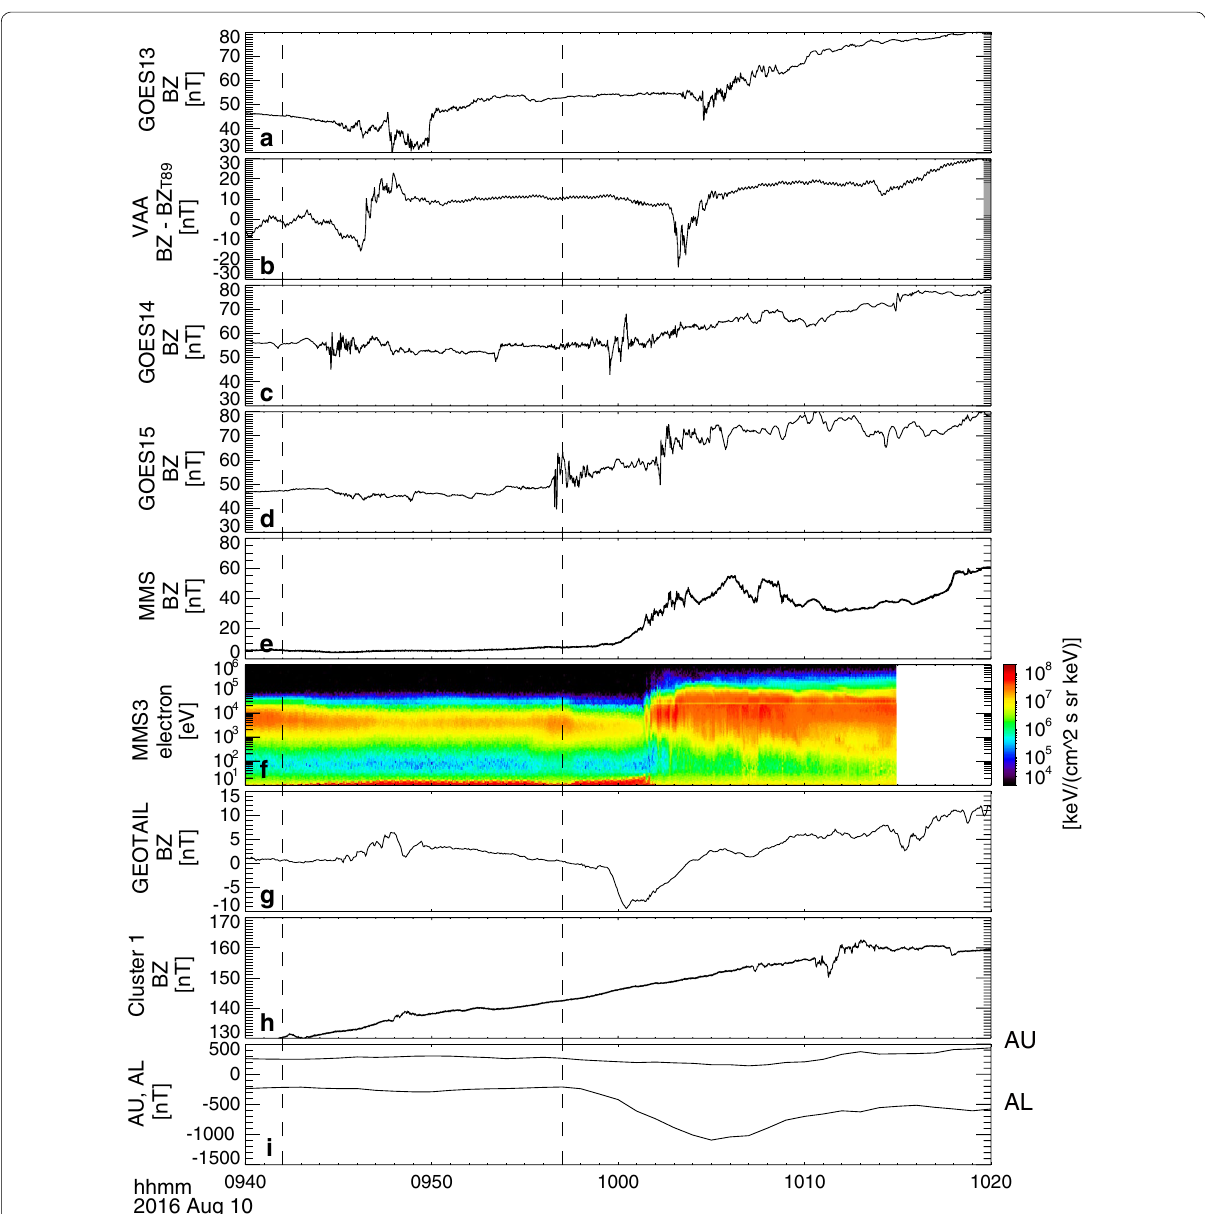
Fig. 2 Multispacecraft observations of dipolarization. Magnetic field component normalized to the current sheet ( B Z ) observed in the night‑side magnetosphere is plotted from the post‑midnight to pre‑midnight regions: a GOES 13, b Van Allen Probe‑A, c GOES 14, d GOES 15, e MMS3, g Geotail, h Cluster 1, together with f a combined product of energy spectra of electrons from MMS1 and MMS3 and i auroral electrojet indices. Elec‑ tron spectra for energy lower/higher than 25 keV are plotted using MMS3 FPI/MMS1 EIS data. For VAA traversing B Z , the difference from the model magnetic field (T89) is plotted. The vertical line indicates 09:42 and 09:57 UT, which are the positive bay onset